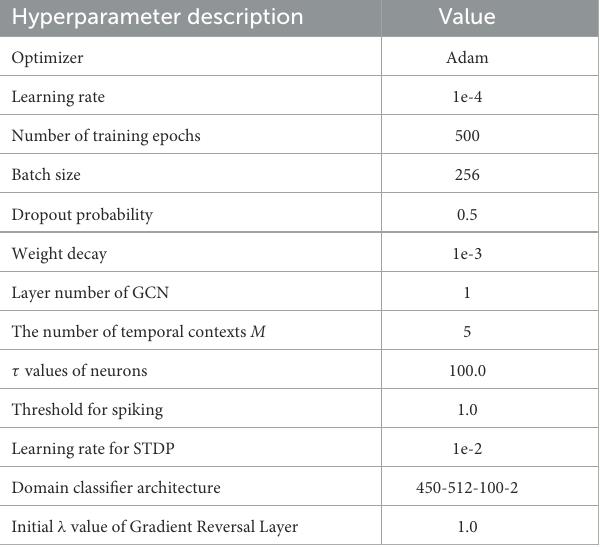
TABLE 1 Experiment hyperparameter